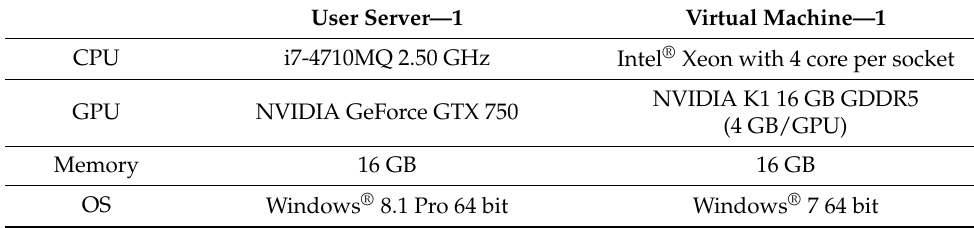
Table 11. Condition 1 of test simulation.